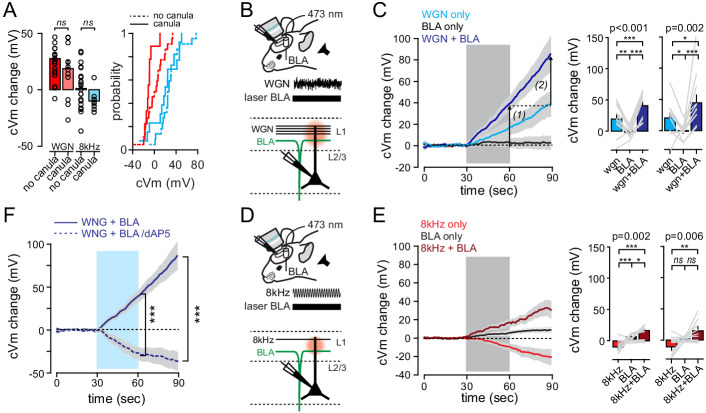
The activation of BLA-to-FrA axons supports the non-linear integration of auditory tones.(A) Optical fibers implantation (canula) do not affect auditory-induced cVm changes as compared to non-implanted mice (no canula). (B) Co-activation protocol. ChR2-expressing BLA neurons were photo-stimulated during WGN auditory stimulation. (C) Averaged cVm changes (±sem) in response to BLA photo-stimulation alone (black), WGN presentation alone (light blue) and WGN+BLA (dark blue). Arrows, analysis time points 1 (end of stimulation) and 2 (30 s later). *, p<0.05; **, p<0.01; ***, p<0.001; Holm-Sidak multiple comparisons after one-way anova (p<0.001 for time point 1; p=0.002 for time point 2). (D, E) Same presentation as in (B, C) but for 8 kHz. (F) Averaged cVm change (±sem) during WGN+BLA co-stimulation in controls (solid line) and after dAP5 application (dashed line). ***, p<0.001; t-test.Figure 5—figure supplement 2—source data 1.Sound and BLA-evoked depolarization.